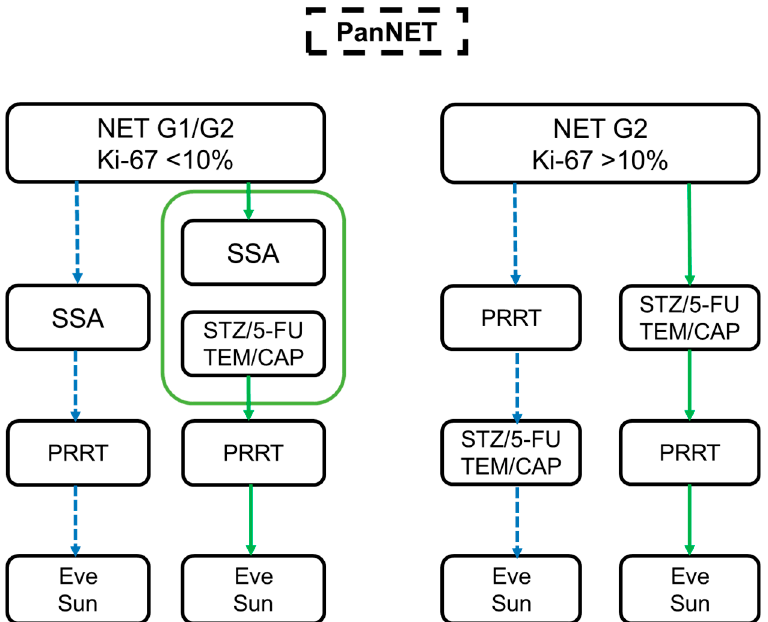
Figure 4. Summary of the survey. Treatment algorithm in pancreatic NETs based on different case scenarios for NET G1/G2 Ki-67 <10% ( left side) and NET G2 Ki-67 >10% ( right side). The dotted blue arrows represent the use of PRRT before CTx and TKI therapy (Eve and Sun), while the green arrows indicate the PRRT after SSA/CTx.